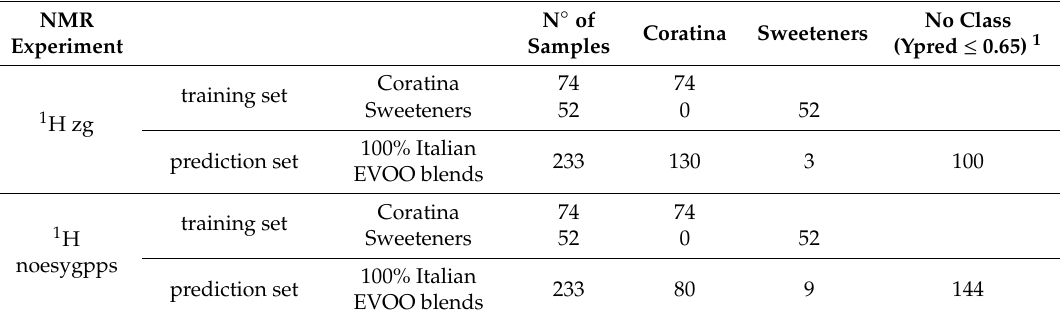
Table 3. Misclassification table summarizing the classified observations in the OPLS-DA models built with bucket reduced zg and zg-noesy NMR